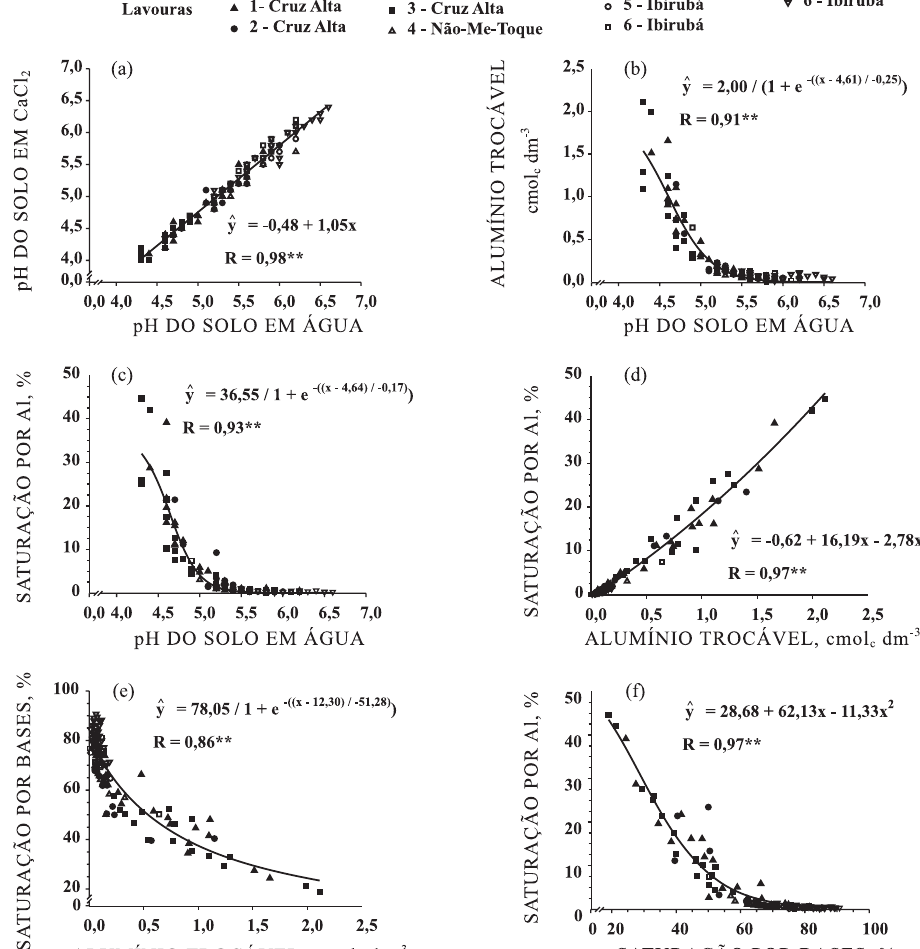
Figura 5. Relação entre o pH em água e o pH em CaCl (a), o alumínio trocável (b), a saturação por alumínio 2 (c), entre o alumínio trocável e a saturação por alumínio (d), a saturação por bases (e) e entre a saturação por bases e a saturação por alumínio (f), em amostras de solo coletadas na camada de 0–10 cm de profundidade, em lavouras no